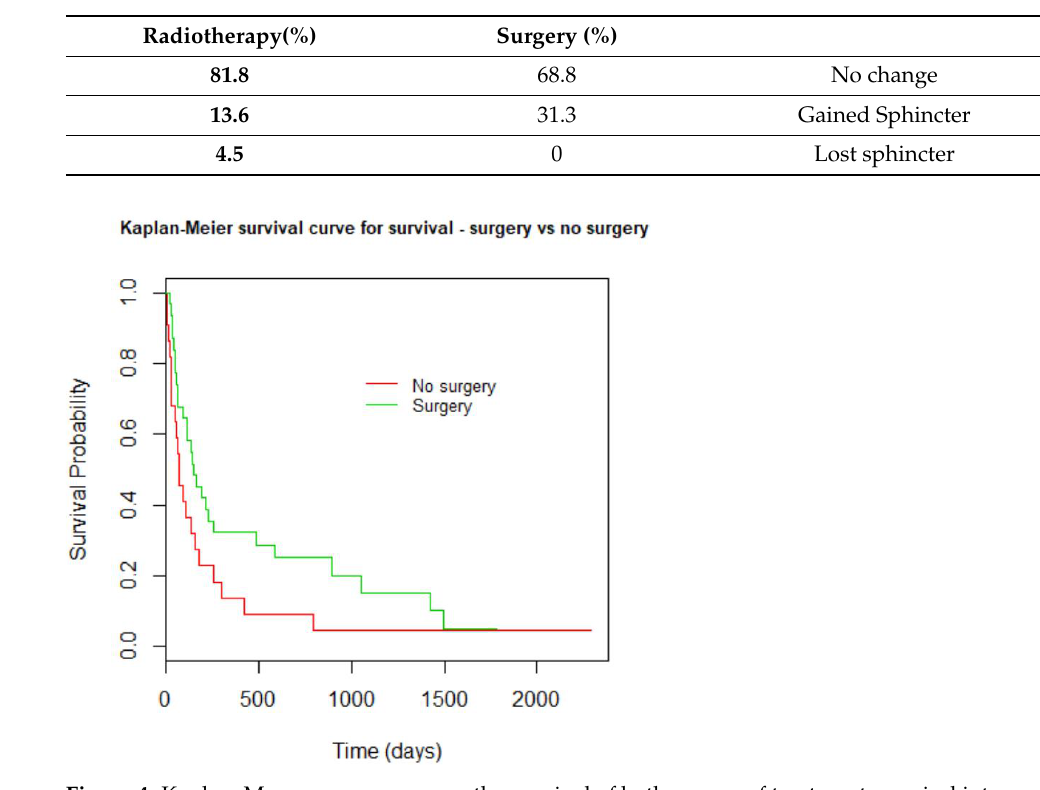
Table 4. Sphincter function changes following the intervention.